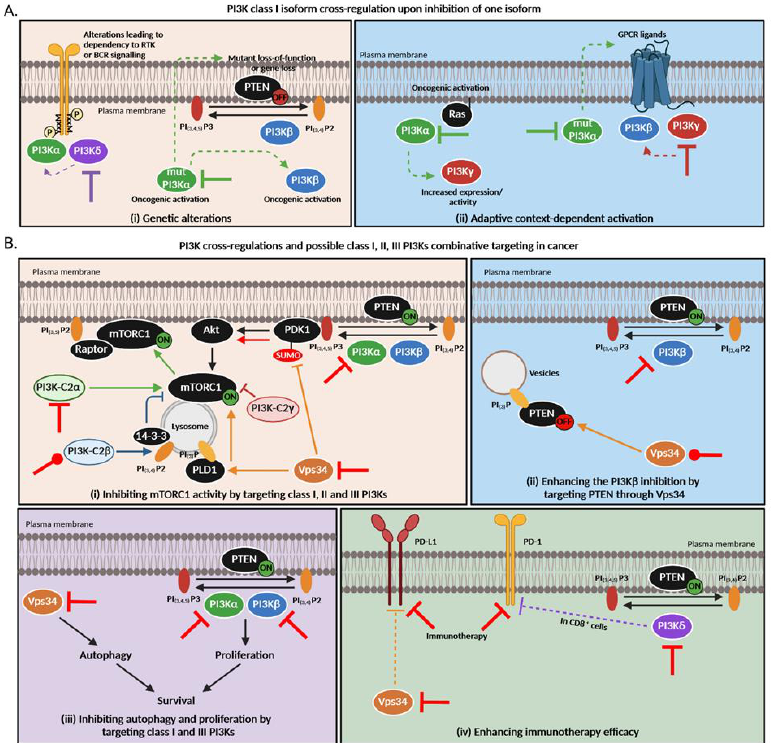
Figure 3. PI3K cross-regulations and possible class I, II and III PI3Ks combination targeting in cancer. A . PI3K class I isoform cross-regulations upon inhibition of one isoform. Thick lines = primary inhibition, dashed arrows = subsequent regulations. B . PI3K cross-regulations among different clas- ses are still poorly understood but based on this knowledge, new therapeutic strategies arise to